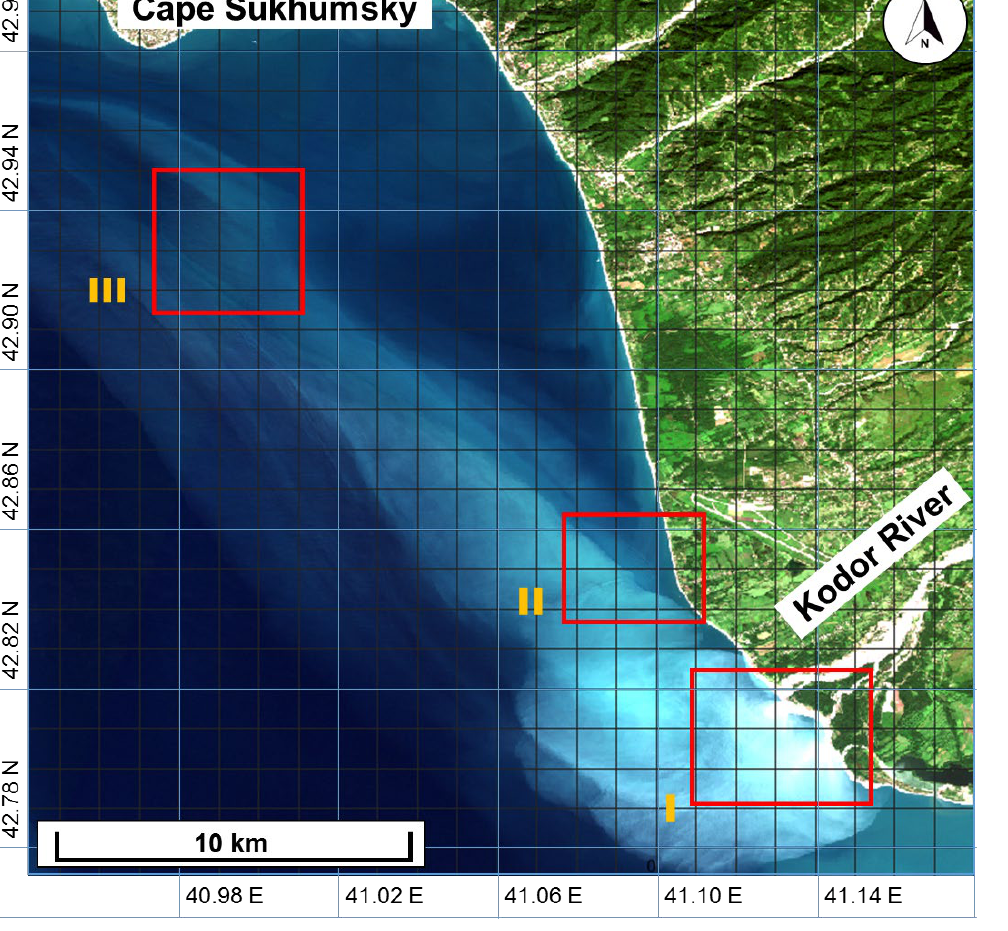
Figure 3. Plume from the Kodor River and examples ( I – III ) of manifestations of periodic structures on the sea surface associated with both internal and surface waves (Sentinel-2, 10 September 2017).